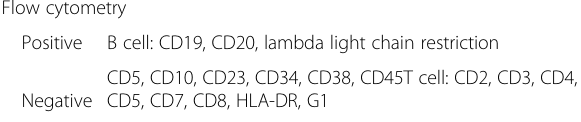
PCR genetic clonality test Positive B cell monoclonality (IGH rearrangement)